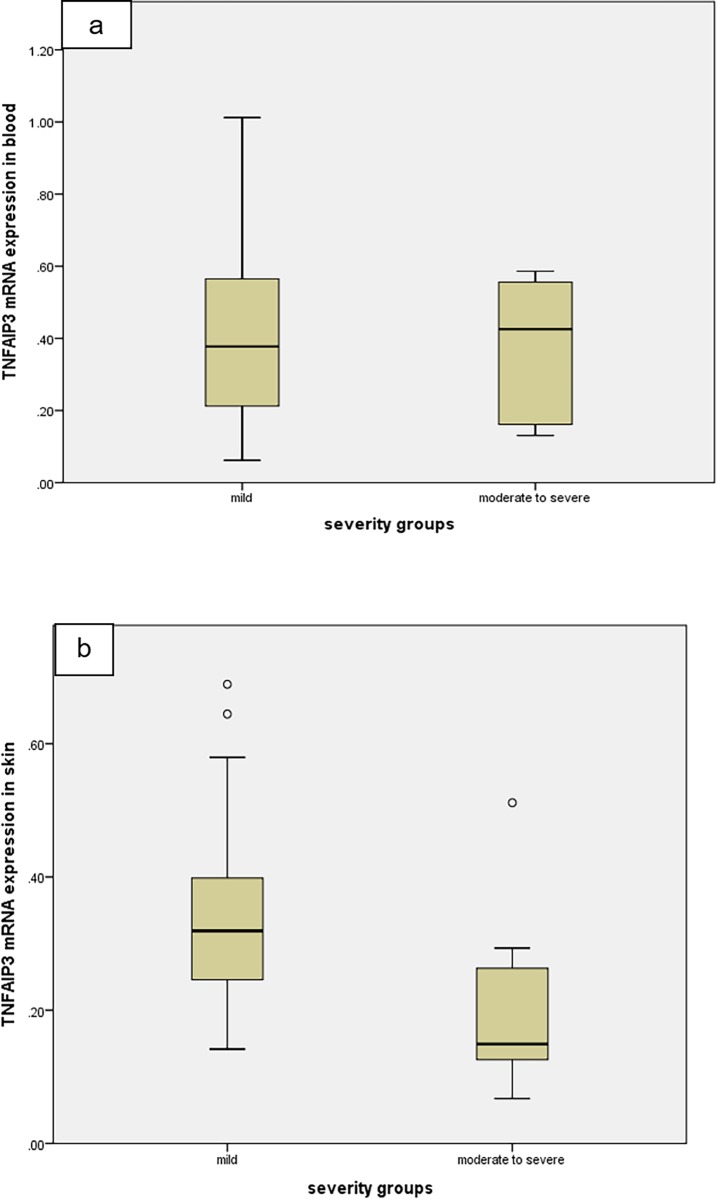
Comparison between mild and moderate/severe cases regarding TNFAIP3 mRNA levels in blood and skin biopsies.(a) TNFAIP3 mRNA in blood (P = 0.914) and (b) TNFAIP3 mRNA in skin (P = 0.004). o = extreme cases.